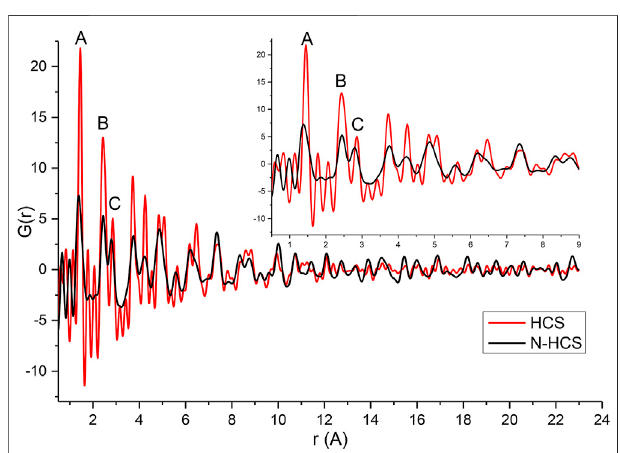
FIGURE 3 | Experimental G(r) of HCSs and